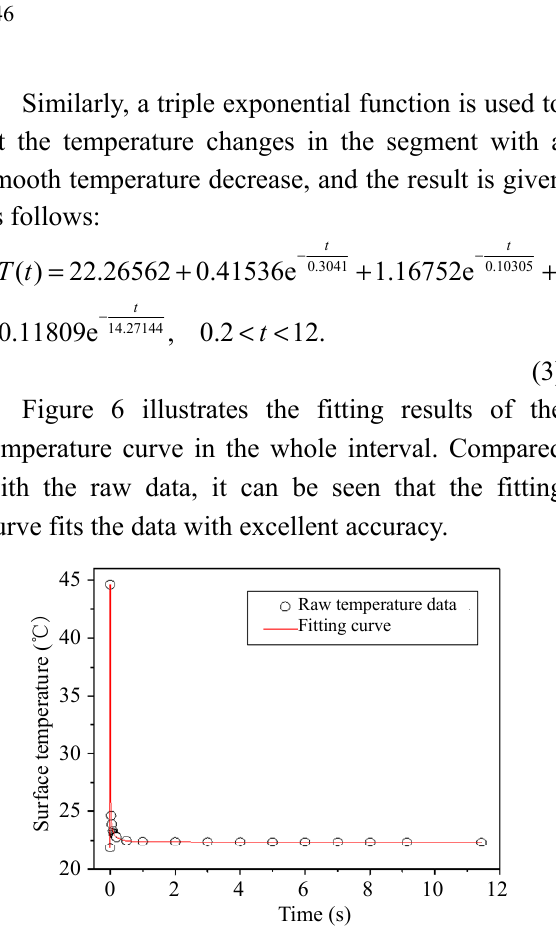
Fig. 6 Temperature curves of the primitive and the reconstructed.